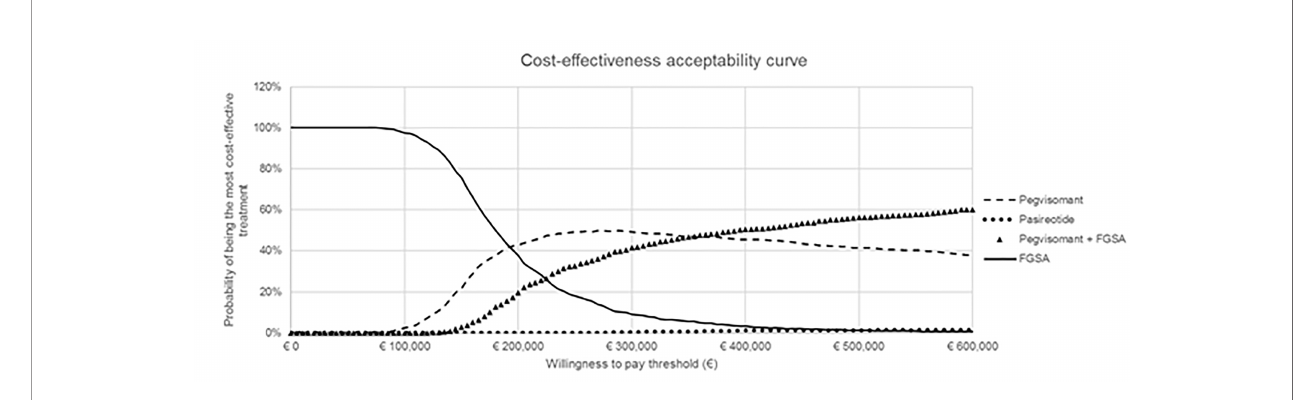
FIGURE 3 | Cost-effectiveness acceptability curve.